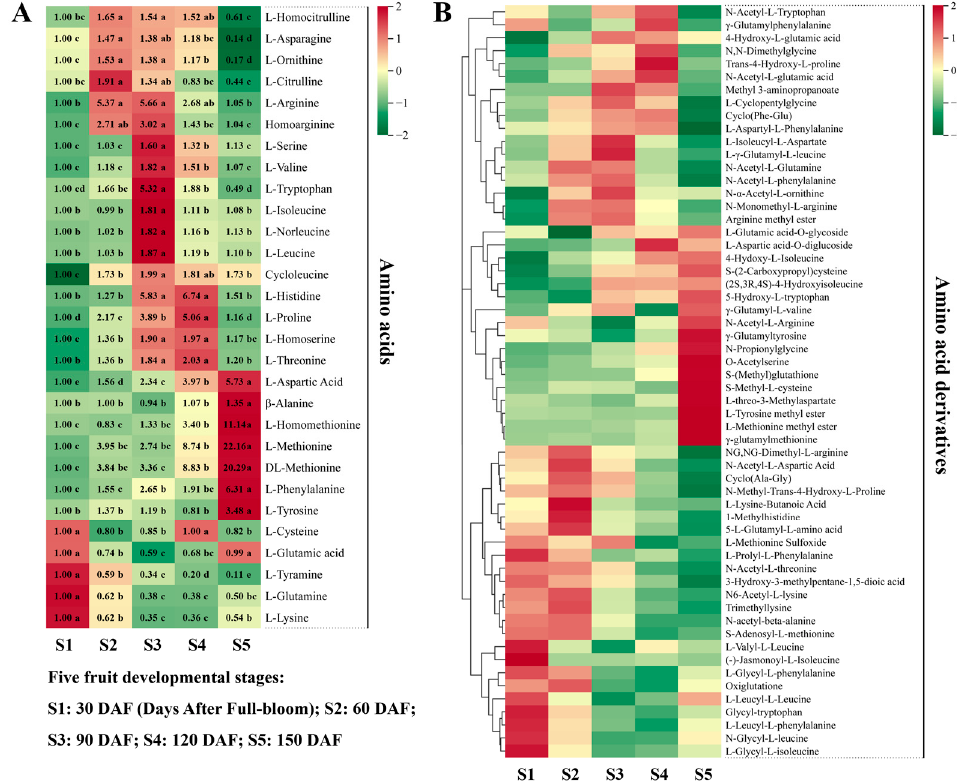
Figure 4. Amino acids (left) and their derivatives (right) detected through broadly targeted UPLC- MC/MS at the five fruit developmental stages. ( A ) Ploidy changes in each amino acid metabolite across the five periods of fruit development are depicted in heat map format; Significance analysis was performed using SPSS software with Tukey’s test and using a threshold of p < 0.05, the results are indicated by lowercase letters a, b, c, d, and e in the figure. ( B ) heat map of the metabolism of amino acid derivatives.